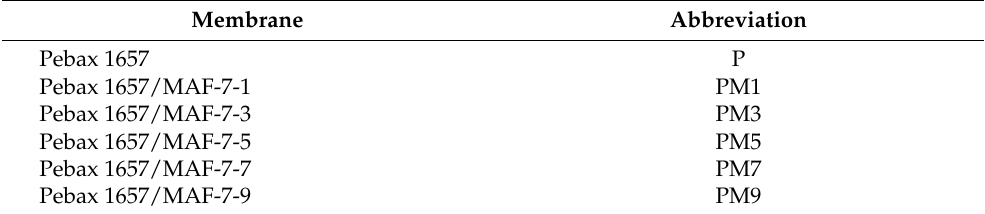
Table 1. Membranes fabricated in this